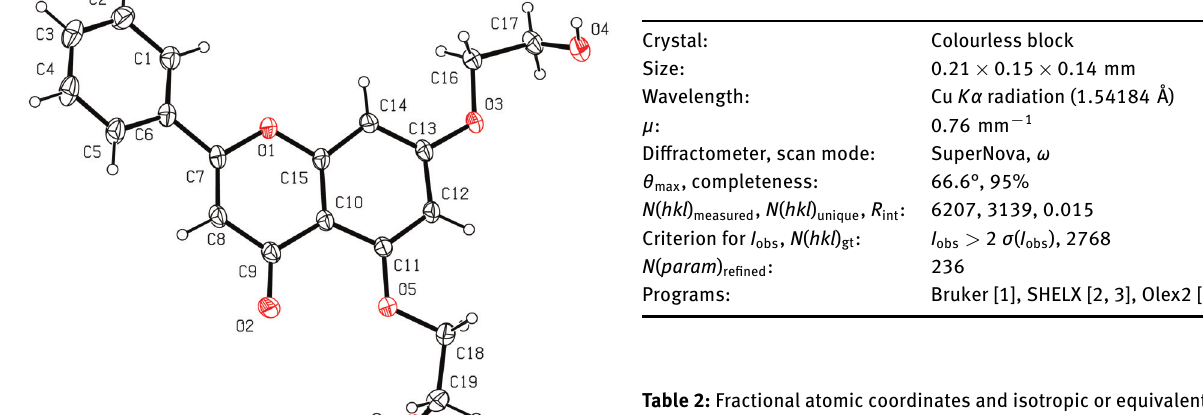
Table 2: Fractional atomic coordinates and isotropic or equivalent isotropic displacement parameters (Å 2